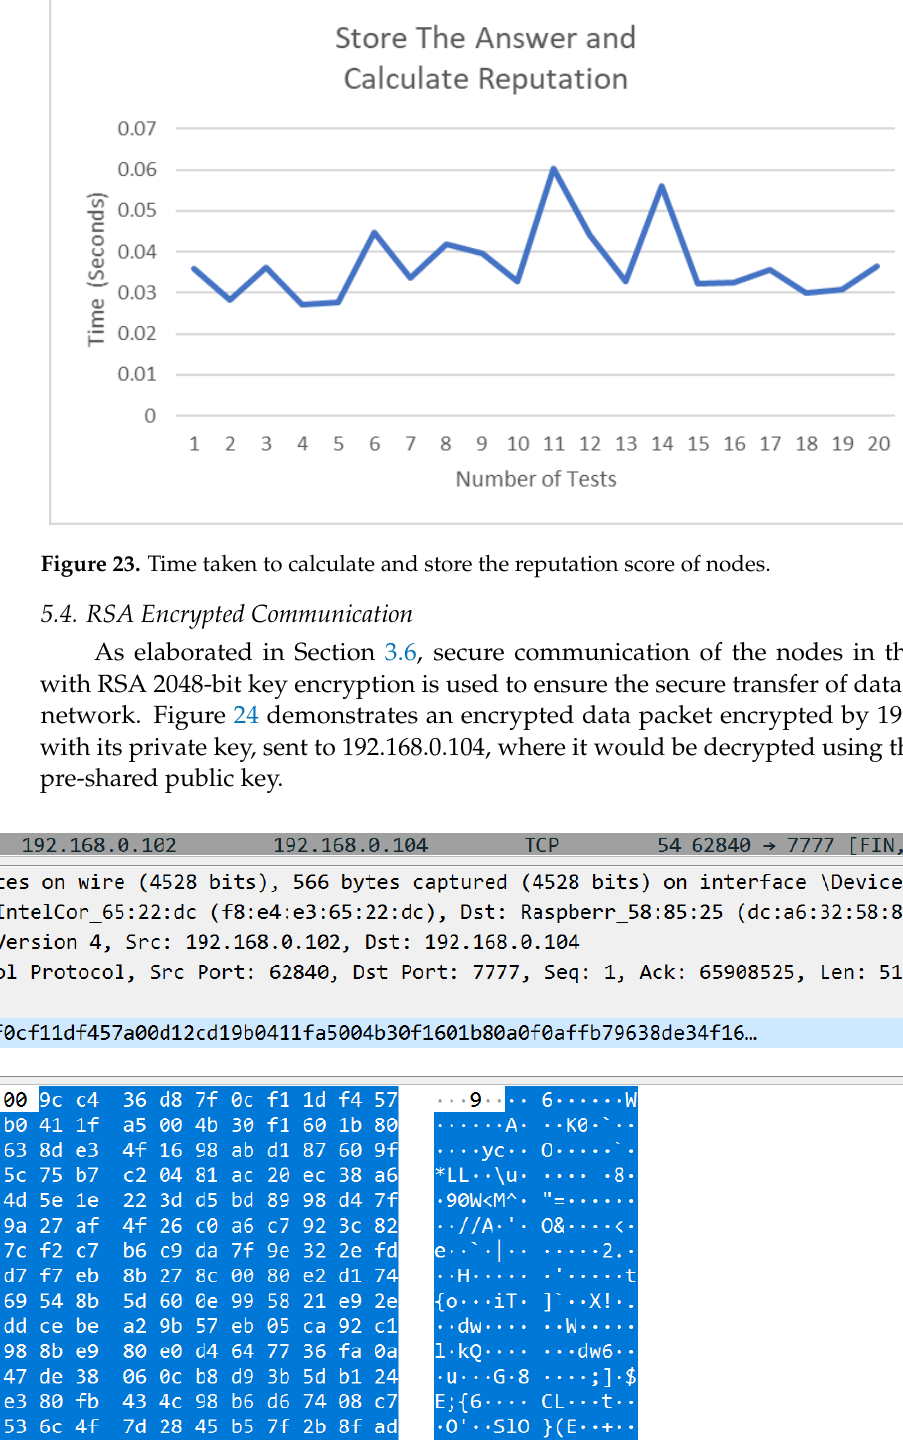
Figure 24. Wireshark snapshot of the encrypted data frame.